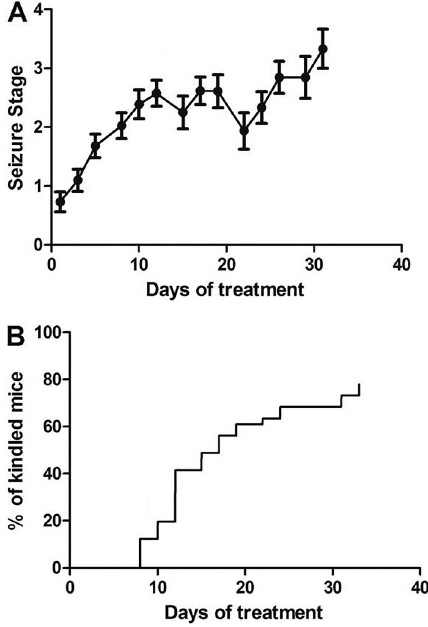
Figure 1. Time-course for induction of kindling (n=32) after repeated pentylenetetrazol (35 mg/kg, ip ) administration. Results are reported as medians and interquartile range of seizure stage ( A ) and the cumulative percentage of the total number of kindled mice ( B